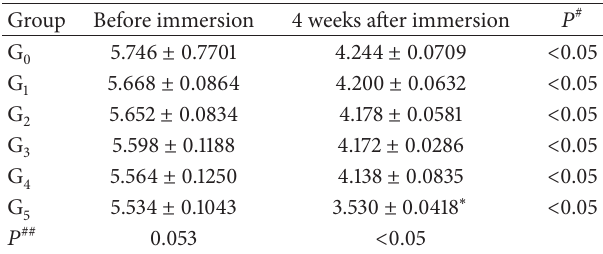
Table 3: Shear strengths of the metal-bone cement interfaces (MPa) before immersion and 4 weeks after immersion in each